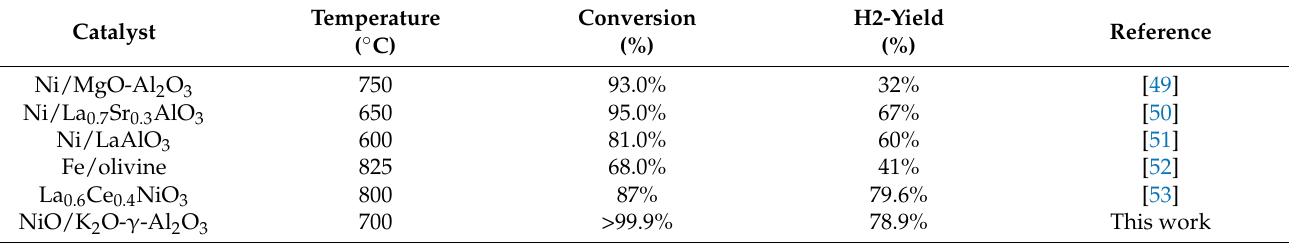
Table 1. A comparison with the reported catalysts for toluene steam reforming.